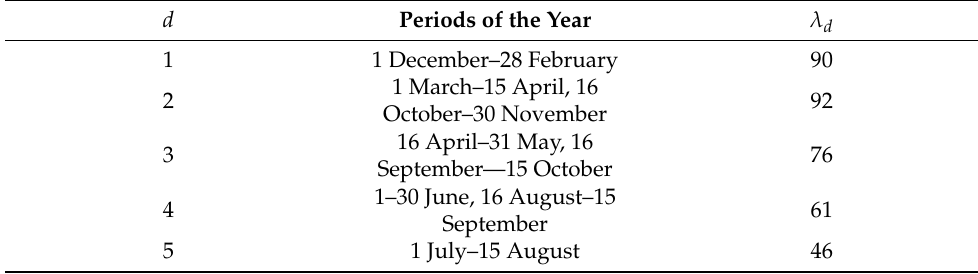
Table 3. Reference days considered in the